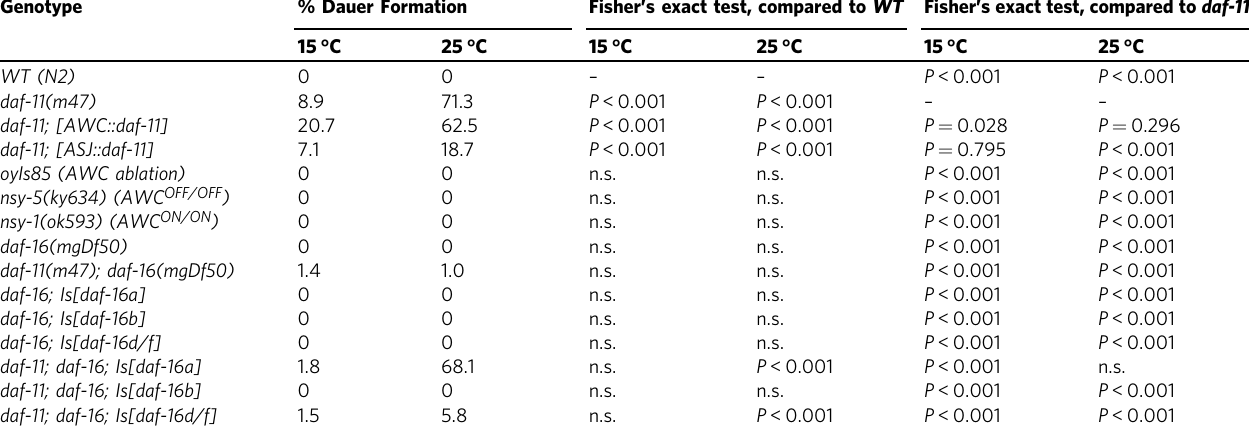
Table 1 Dauer formation and lipid metabolism are regulated via distinct neural circuits and DAF-16/FOXO isoforms.